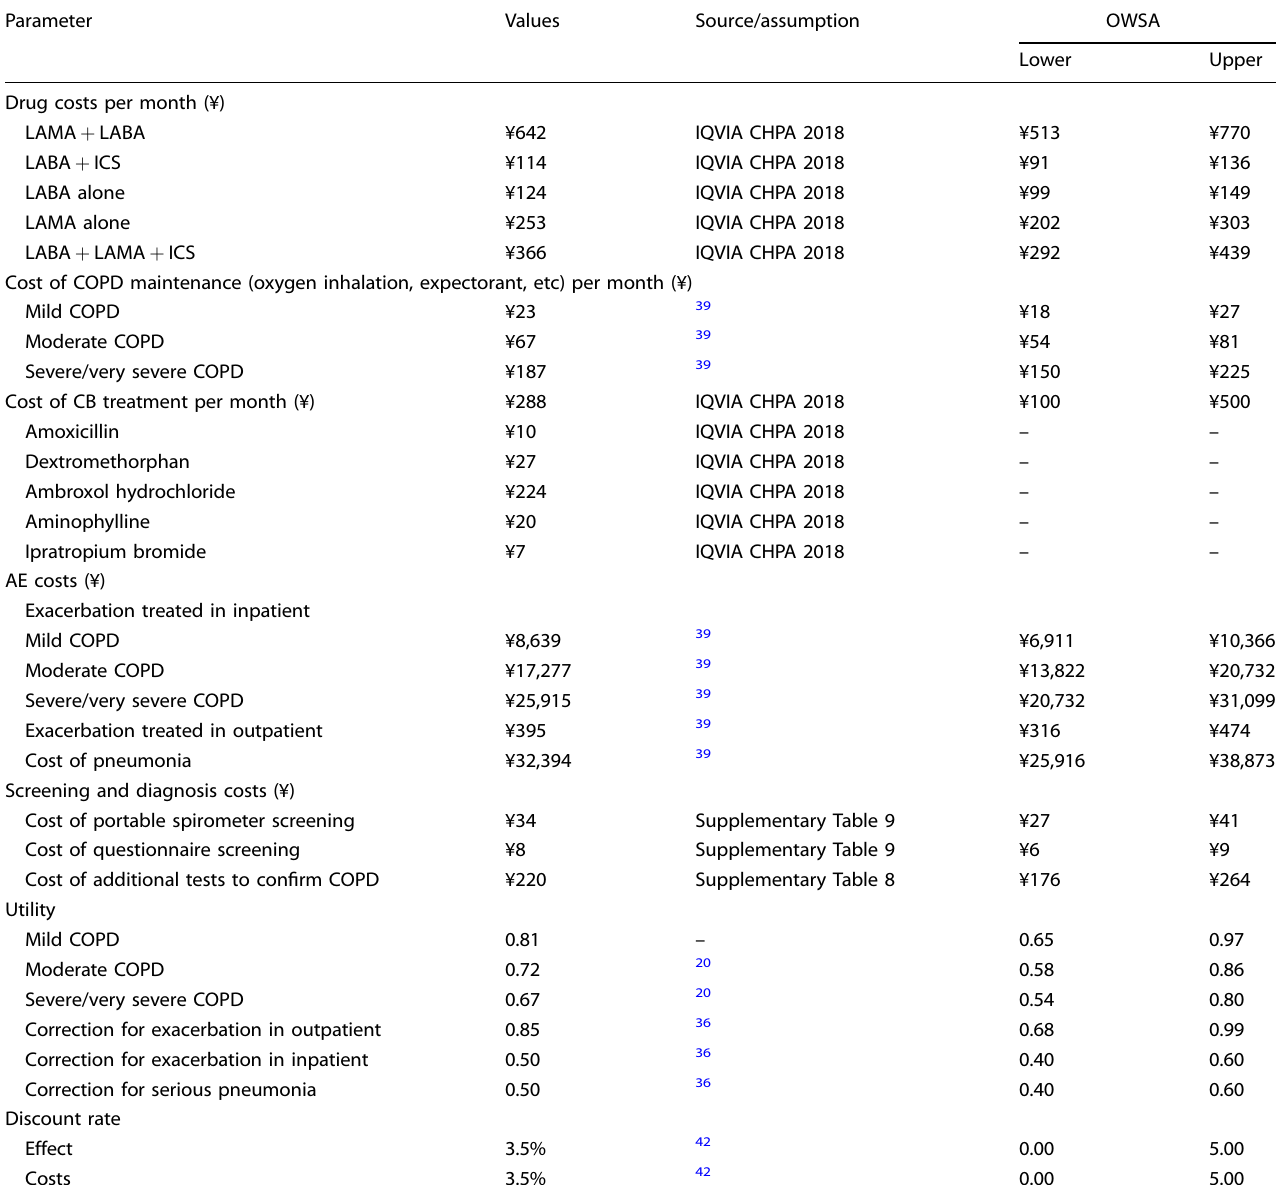
Table 5. Cost, utility, and discount rate